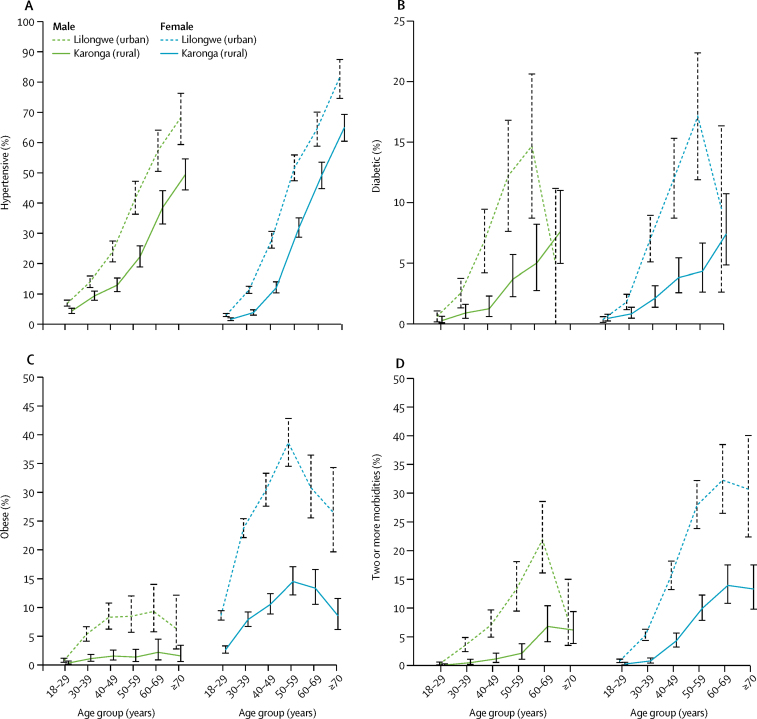
Age-specific and sex-specific prevalence of hypertension, diabetes, obesity, and multimorbidity by sitePrevalence point estimates are presented with (vertical) 95% CIs.